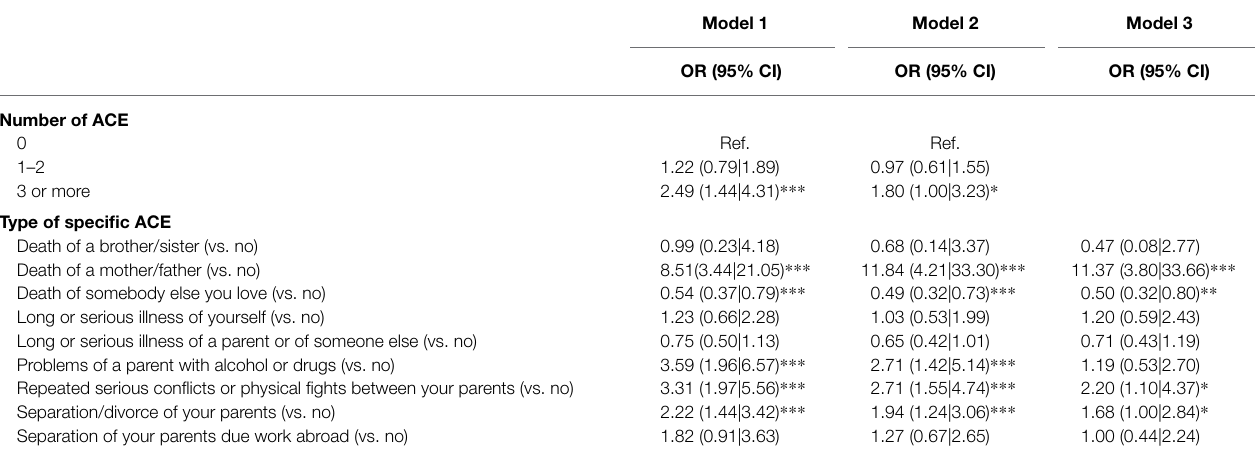
TABLE 2 | Association between ACE (number and type of specific) and use of psychosocial care; results from logistic regression models leading to odds ratios (OR) and 95% confidence intervals (95% CI), crude (Model 1), adjusted for confounders (age, gender and socioeconomic position; Model 2), and adjusted for the associations with other ACE (Model 3; Care4Youth study, collected in 2017–2018, Slovakia, 10–16 years old, N =